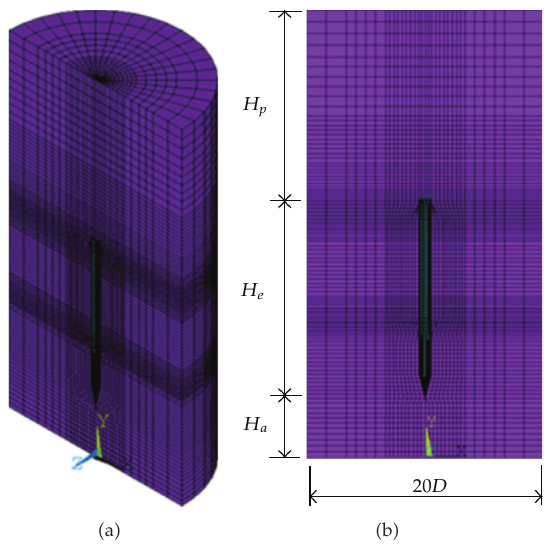
Figure 3: General view of a typical FE mesh.